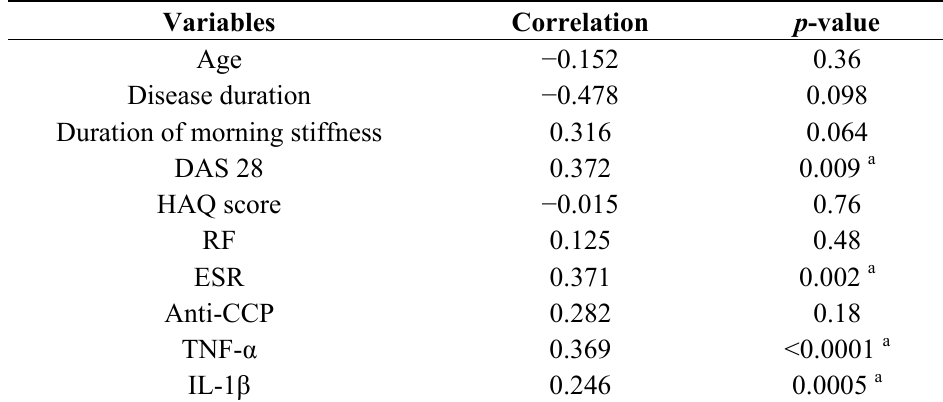
Table 2. Correlations between miR-155 expression and the various clinical and laboratory data of patients with rheumatoid arthritis ( n =